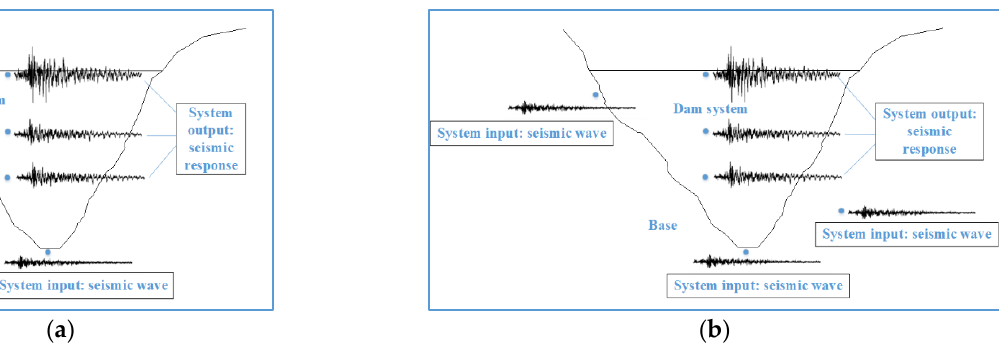
Figure 2. The input – output system of a concrete dam: ( a ) uniform support excitation; ( b ) non-uniform multiple-support excitation.